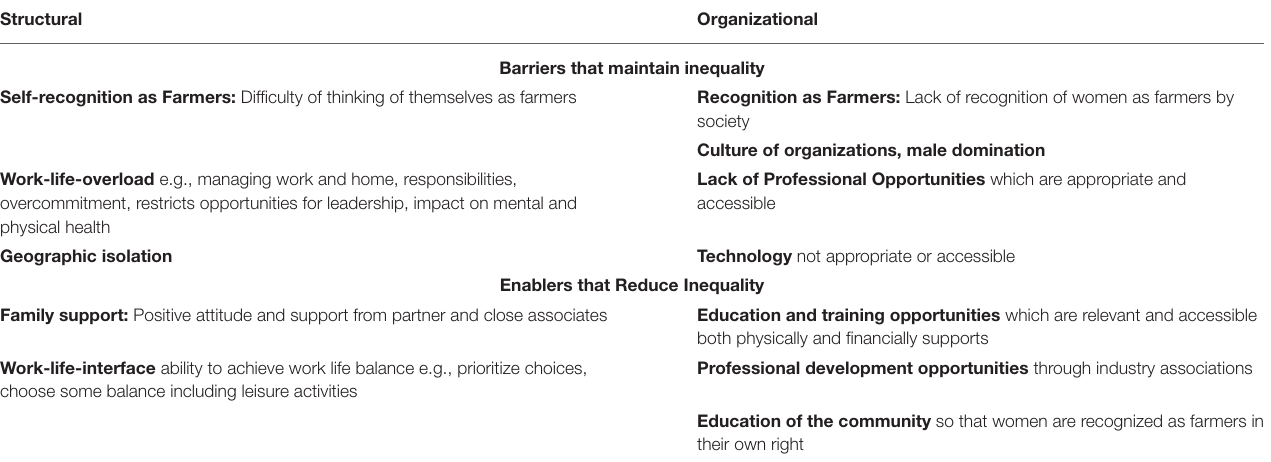
TABLE 2 | Barriers and enablers that maintain and reduce gender inequality of Queensland farm businesswomen.